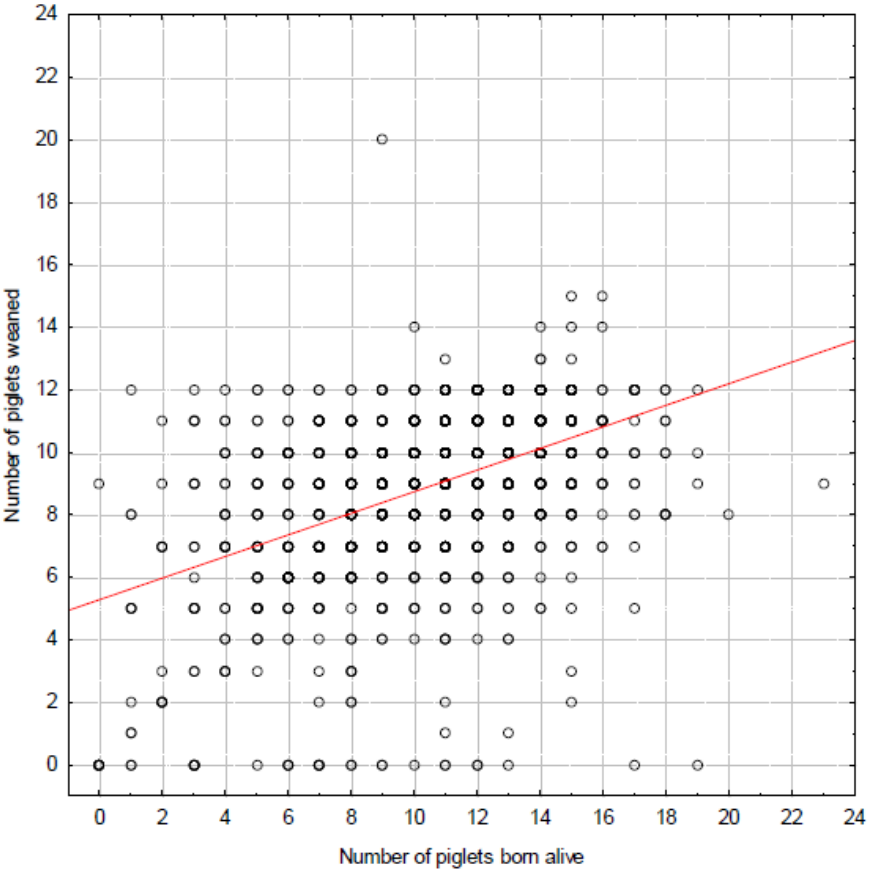
Figure 6. Relationship between the number of piglets born alive and weaned. Because piglets from sows with many young are fostered to sows with fewer piglets, the relationship between farrowed and weaned is not linear, i.e. the regression line (solid line) does not match linearity (slope = 1; dotted line). Piglet losses due to predation are likely evident in sows that were recorded as having few piglets born (rectangle; i.e., piglets were lost before they had been recorded), or for sows weaning far fewer piglets than were born